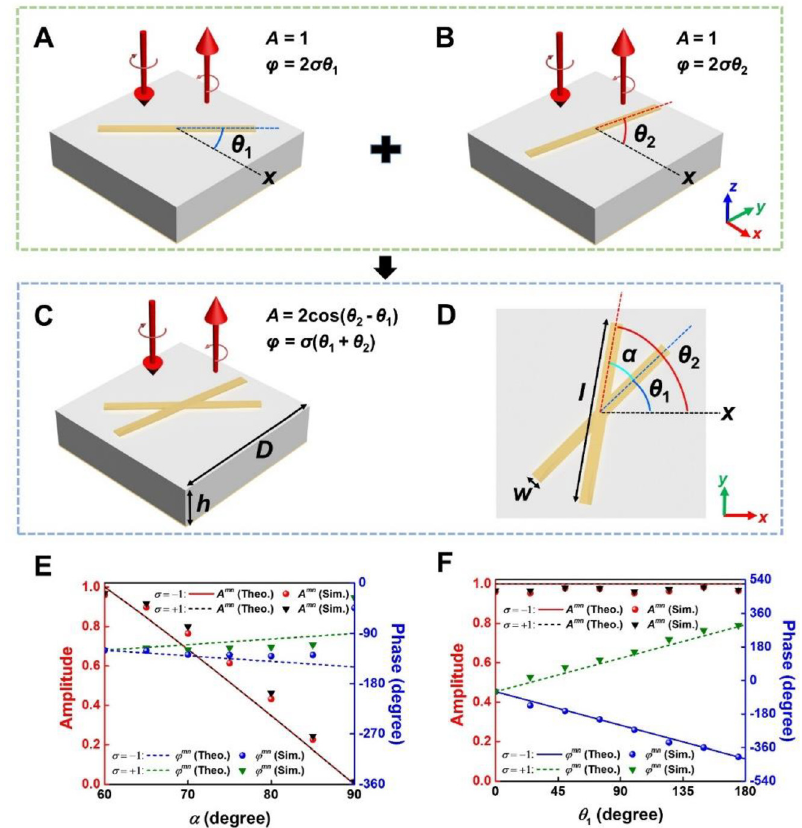
different powers (denoted by B that the incident source is right-handed circularly polarized (RCP) wave, and the corresponding radiation property for left-handed circularly polarized (LCP) incidence will be discussed in the next section. Figure 2. We utilize the meta-atom that is a triple-layer struc- ture consisting of top metallic layer, a bottom metallic plane andamiddledielectriclayer.Bycarefullytuningthestructural anisotropy of each rod in the metasurface particle to achieve near-unity re fl ective amplitude for two orthogonal linearly- polarized incidence but with a 180 ° phase difference, the geometric phase will be induced, imparting an additional phase shift of 2 σθ oncethemeta-atomis rotatedby an angleof θ under the normal illumination of CP wave, where the